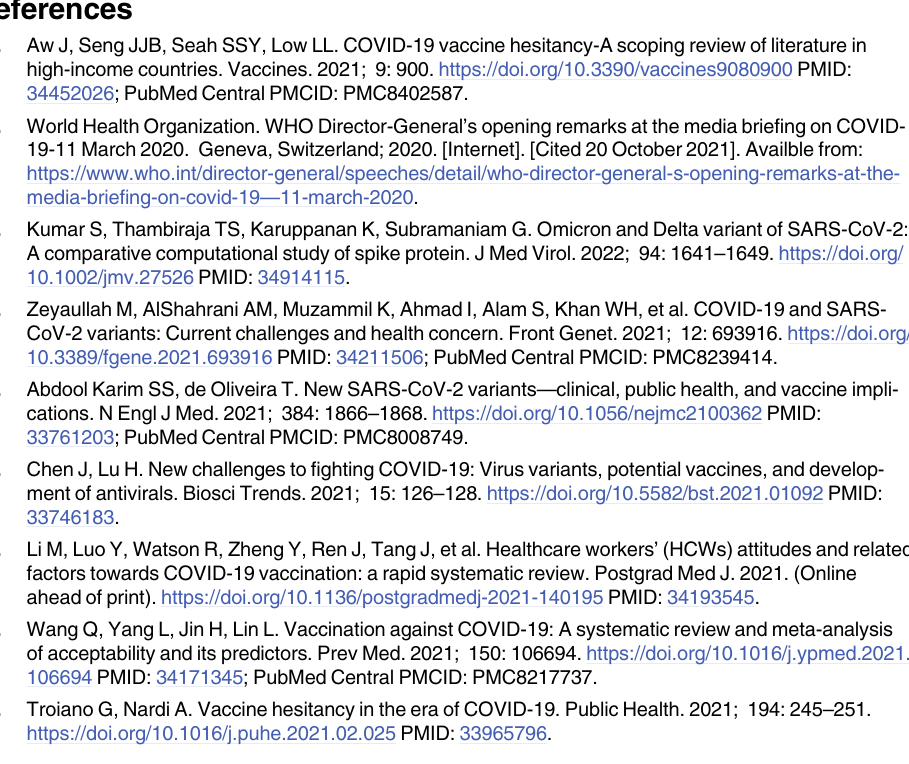
S2 Table. Meta-regression evaluating the effect of sample size of each study on the accep- tance rates (%) of COVID-19 vaccine among dental students and dental